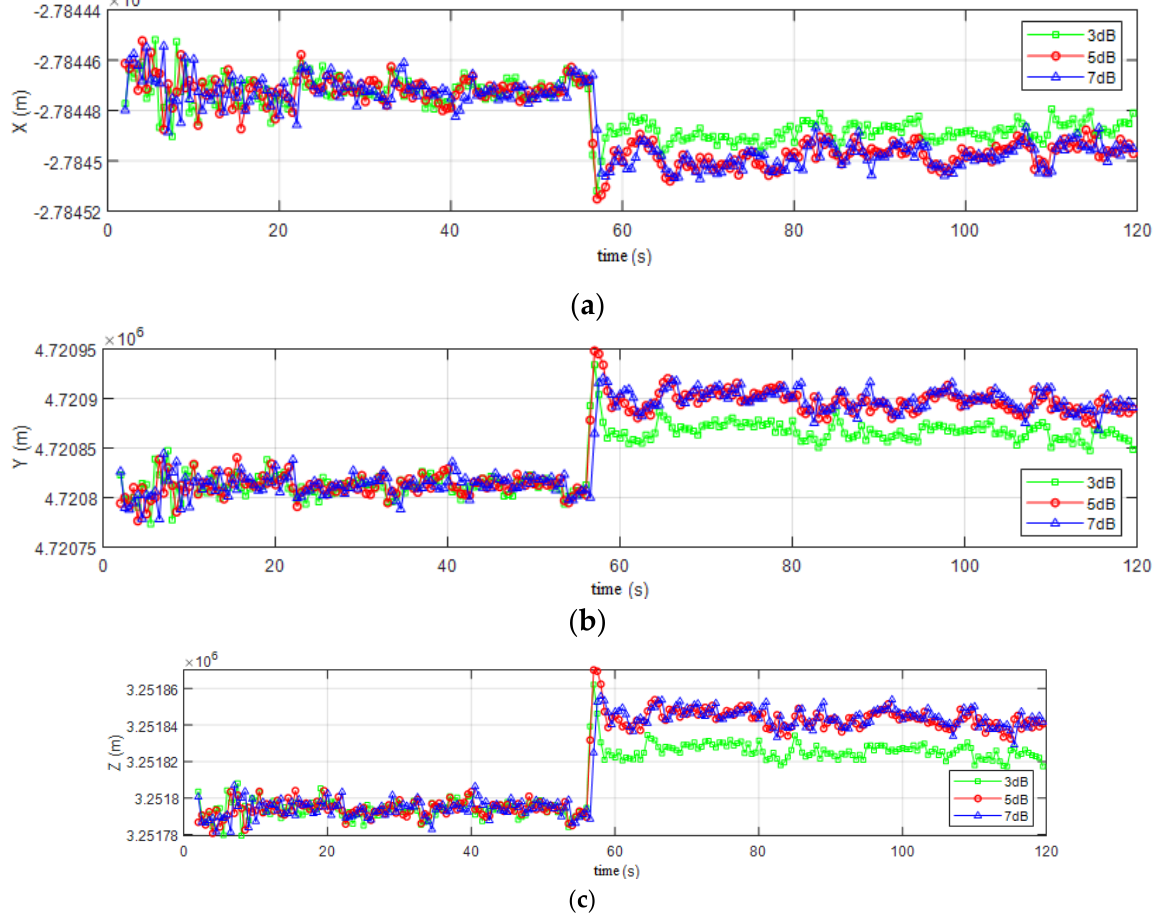
Figure 7. The Position of Receiver in Spoofing Environment: ( a ) Position in X direction; ( b ) Position in Y direction; ( c ) Position in Z direction.